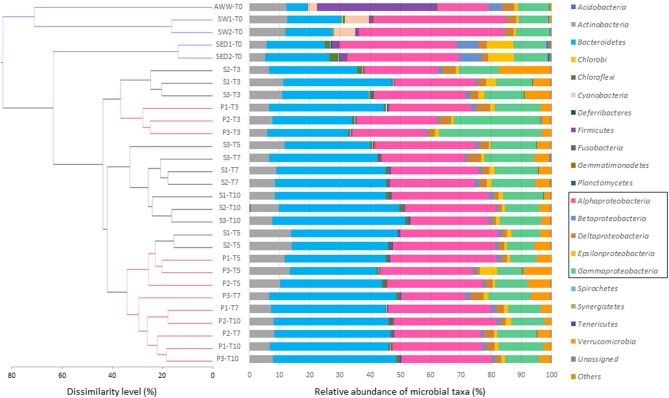
Composition of microbial communities at the phylum or class level in initial sediment (S), seawater (SW), and acid wastewater (AWW) of Sfax coast (south Mediterranean Sea), and in sediment samples collected from biotic incubations with or without AWW addition (S and P conditions, respectively) at 4 different times (T3, T5, T7, and T10 days). Each bar represents the color-coded relative abundance of microbial taxa in the studied samples. The dendrogram was constructed from the OTU abundance table using Bray–Curtis dissimilarity. The scale bar of the dendrogram represents the dissimilarity level (%) between microbial community.